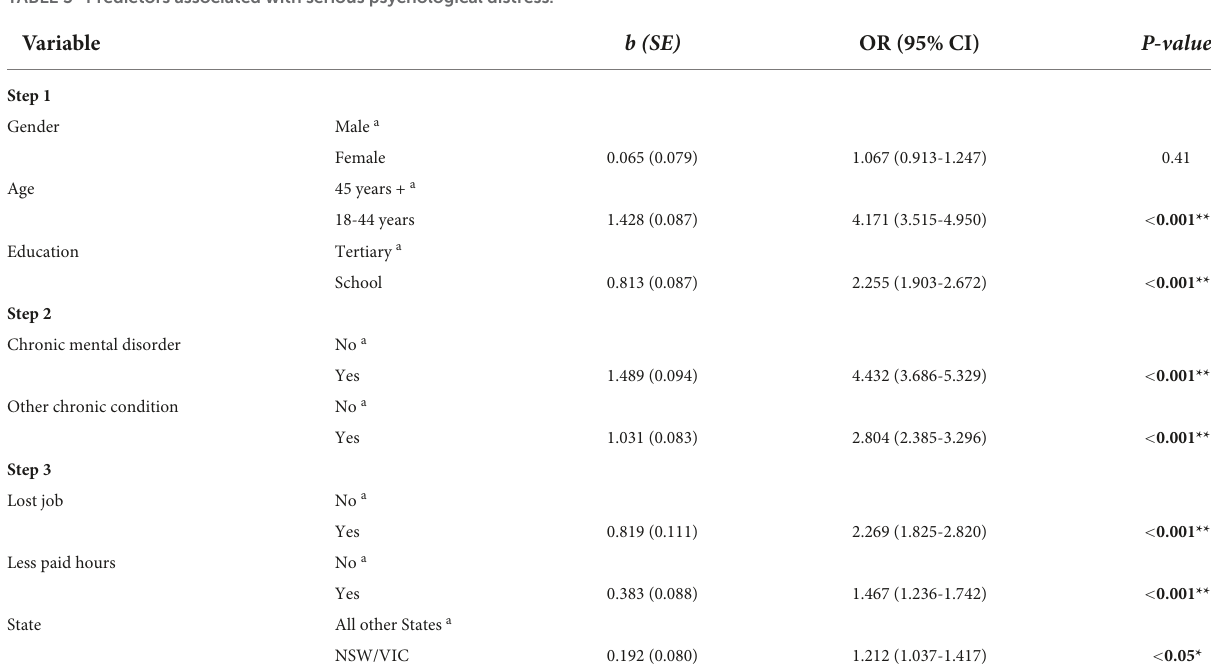
TABLE 3 Predictors associated with serious psychological